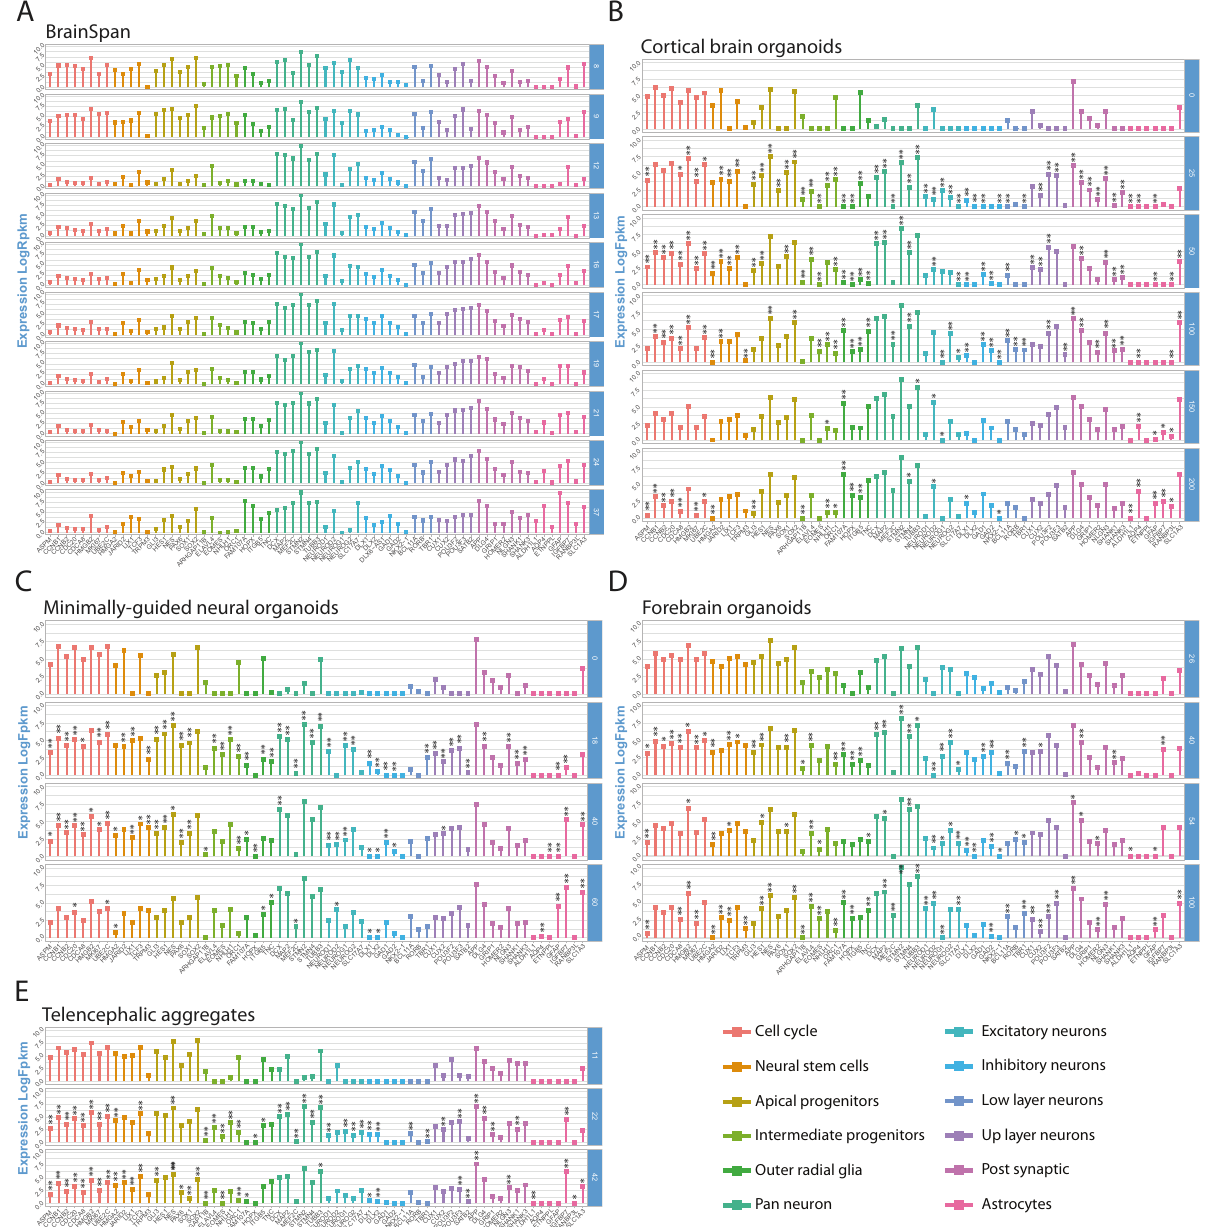
Fig. 5 Gene expression levels of signatures related to cell population identity and function in BO. Expression levels (Log2Fpkm or Log2Rpm) in BS ( A ), CBO ( B ), MGO ( C ), FO ( D ), and TA ( E ) along time-points are reported in each dataset as the mean value across replicates. Each bar color corresponds to a speci fi c signature, as reported in the plot legend. For brain organoids ( B – E ), asterisks identify genes that result signi fi cantly modulated in stage-wise differential expression analyses (comparison of each differentiation stage with the previous) reported in Fig. 2 for CBO and Fig. 4 for the other protocols. **: FDR < 0.05; *: Conventional P -value < observed already at day 40; MGO and TA showed a partial between PCW 9-12, in line with WGCNA results. We found in BO expression at the available time-points. models a less abrupt reduction of cell cycle and apical progenitor Considering that the examined BO protocols were based on markers. The intermediate progenitor signature was found to peak different degrees of guidance and culturing conditions, we then at different time-points across models. looked at brain area-speci fi c genes, markers of off-target tissues, Excitatory neuron markers were particularly expressed at early markers of neurotransmission, and stress-related genes (detailed PCW in the fetal cortex, a trend mirrored by CBO; MGO, FO, and TA in Supplementary Fig. 9, Supplementary Fig. 10, Supplementary showed a more persistent expression throughout differentiation. Table 2). As markers of metabolic stress, we looked at the oRG genes were well expressed in BS at PCW 8 – 9, decreased expression of glycolytic and ER-stress genes [15]. We found from PCW 12 and increased again at later stages, when astrocyte fl uctuations of expression of those genes throughout cortical markers also appeared. CBO showed constant upregulation of the development as well as in BO, however, without indications of a whole oRG signature starting from day 100, while for FO this was